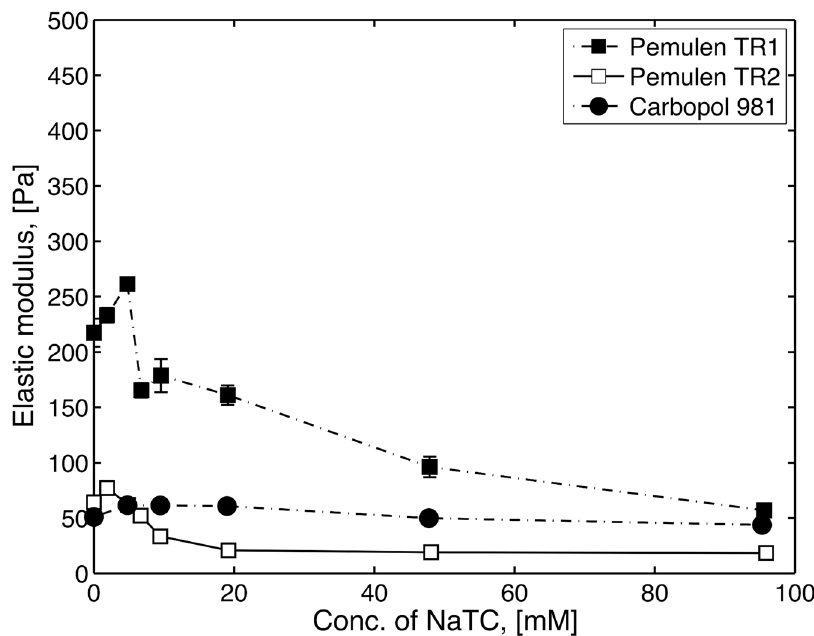
Fig 3. The elastic modulus (G ’ ) at 0.2 Hz as a function of the NaTC concentration of for 1 wt% Pemulen TR1 (filled square), TR2 (open squares) and Carbopol 981 (filled circles). The data points represent the mean values of three samples and error bars show the standard deviation (n =